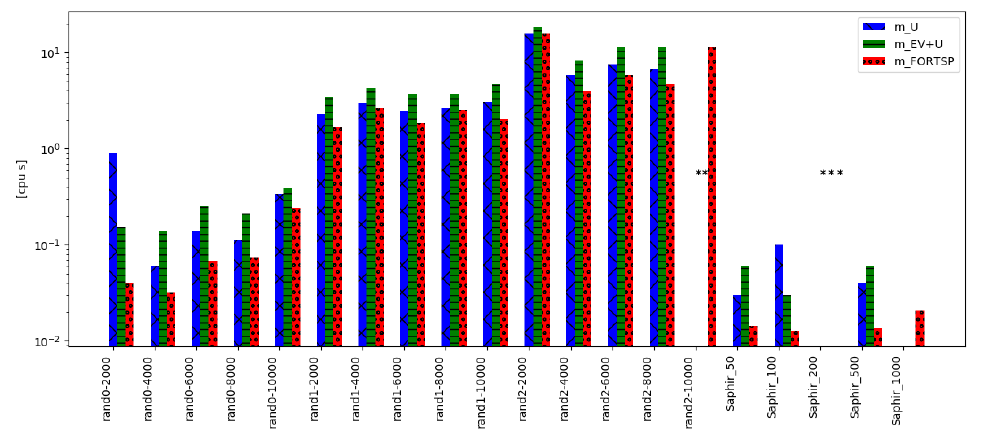
Figure A2. Cumulative solution time of masters problem in BD, where **, *** means the algorithm fails to solve the instance in 10,800 CPU seconds.